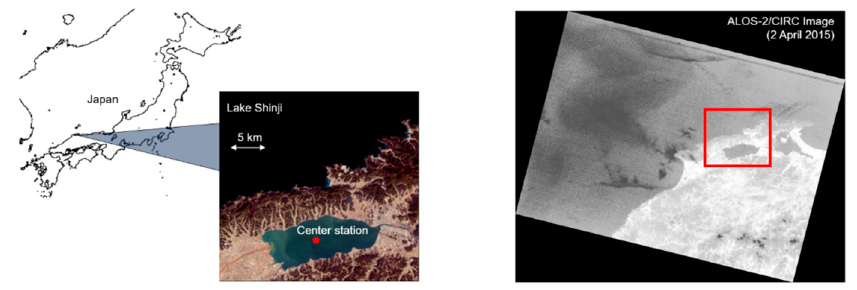
Figure 6. Location of the Tel-VC site in Lake Shinji (left) and the ALOS-2/CIRC image acquired over the lake on 2 April 2015 (right).